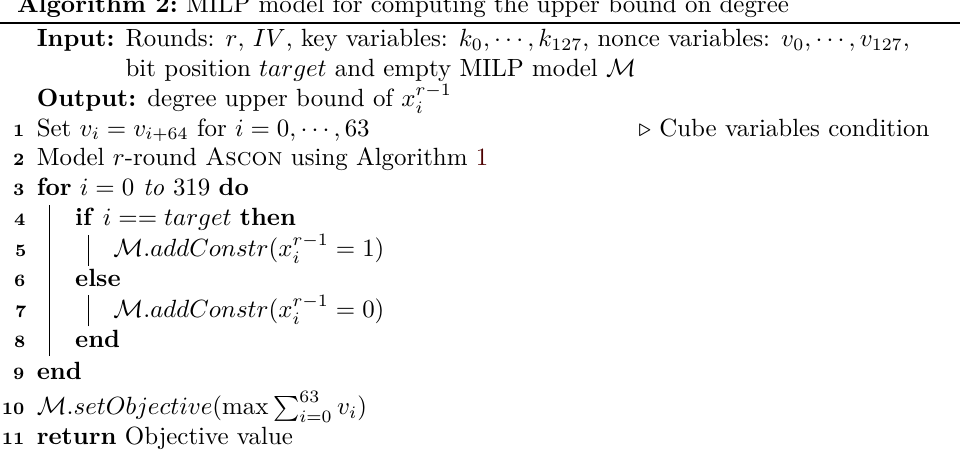
Algorithm 2: MILP model for computing the upper bound on degree